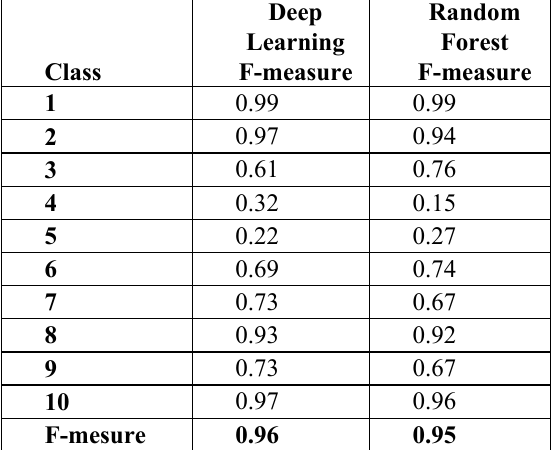
Table 2: F-measure of Deep Learning and Random Forest The outcomes of F-measure for the two algorithms we show very good results for all classes of reed: ‘reed vegetation on salinized soils’ (0.69 for Deep Learning and 0.74 for Random Forest), ‘pure reed vegetation’ (0.73 for DP and 0.67 for RF), ‘reed on open plaur’ (0.93 and 0.92), ‘reed on compact plaur’ (0.73 and 0.67) and ‘reed on compact plaur’ (cut reed) (0.97 and 0.96). The class ‘Dunes’ and ‘Dunes vegetation’ present values a mediocre F-measure for the two algorithms (figure 6).